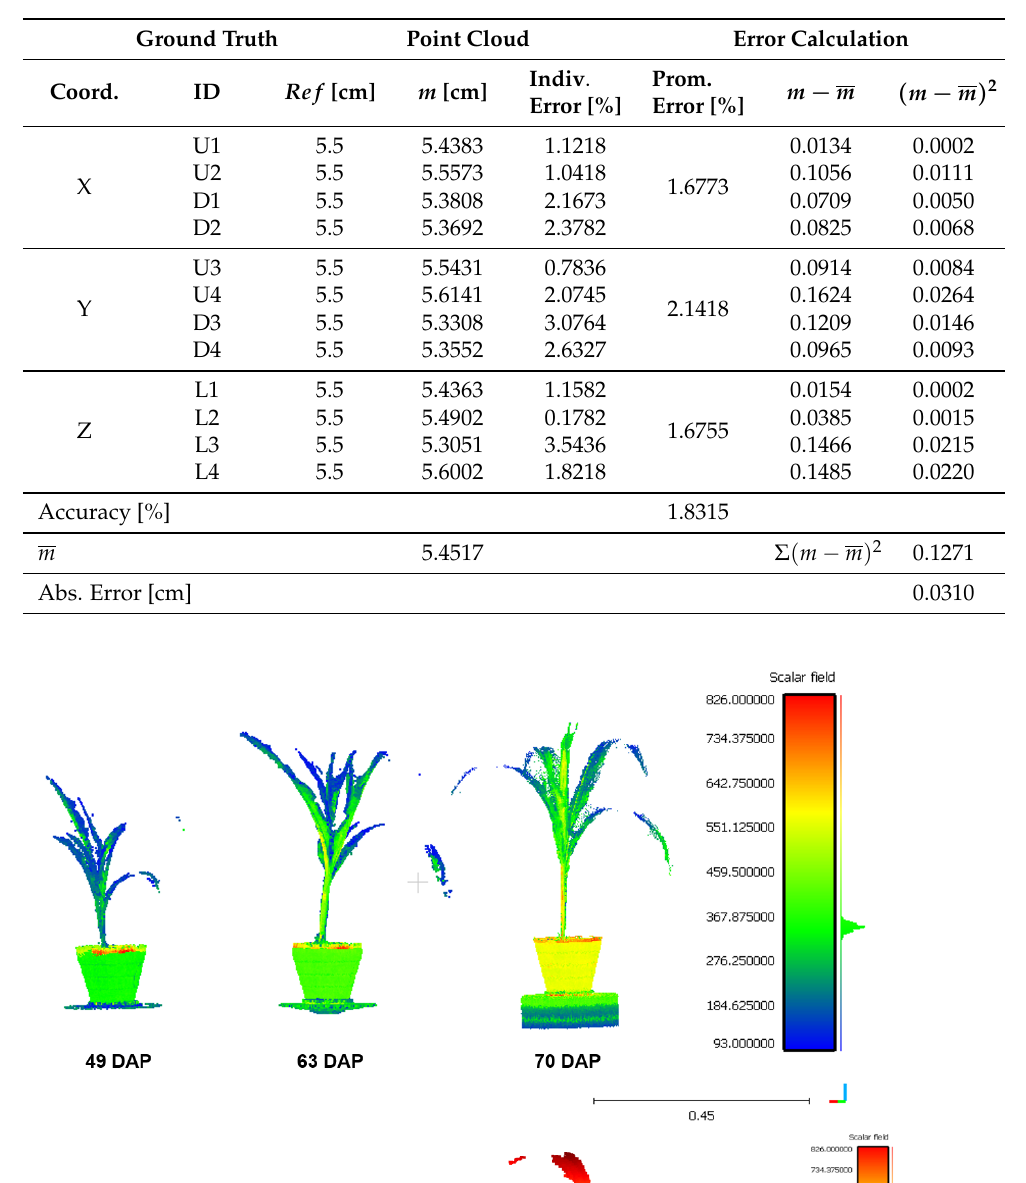
Table 2. Measurement error obtained with the cube’s 3D point cloud.